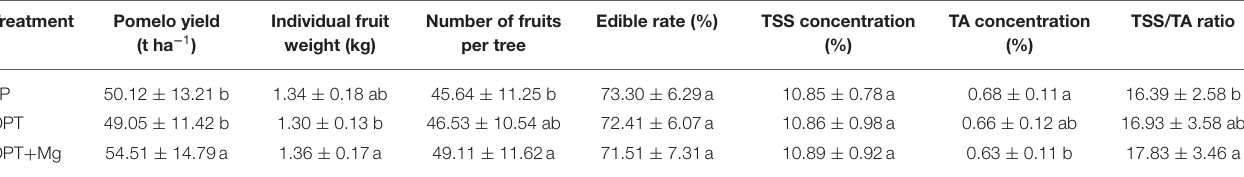
TABLE 2 | Pomelo yield and fruit quality under the different fertilization treatments (Mean ± SD).